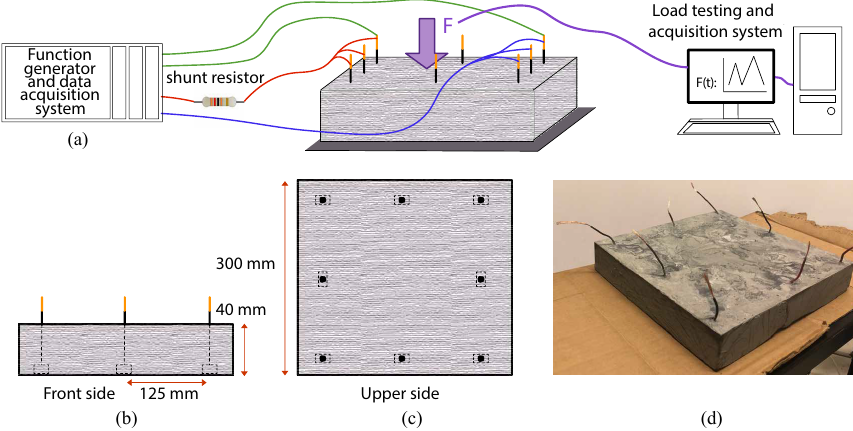
Figure 3. Description of the slab sample for electromechanical tests. ( a ) Sketch of the setup; ( b ) front side view; ( c ) upper side view; ( d ) photo of the plate.